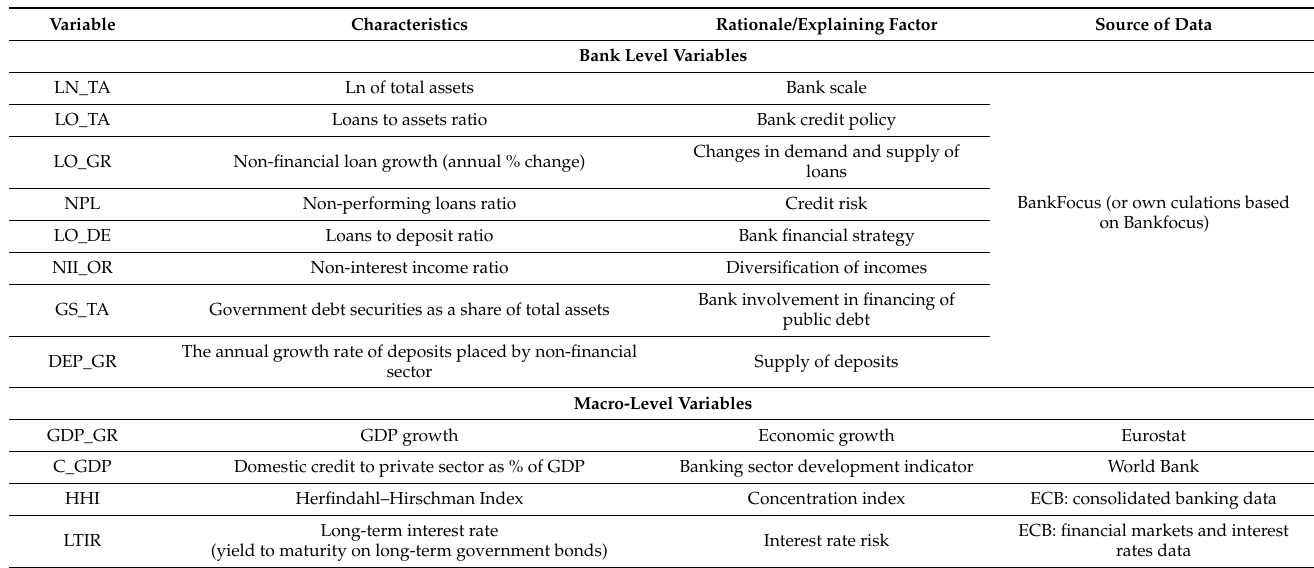
Table 5. Explanatory